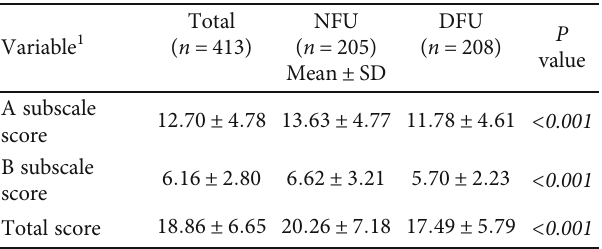
Table 4: DFSBS (diabetes foot self-care behavior scale) scores in diabetic patients and comparison between DFU (diabetic patients with foot ulceration) and NFU (diabetic patients without foot ulceration)